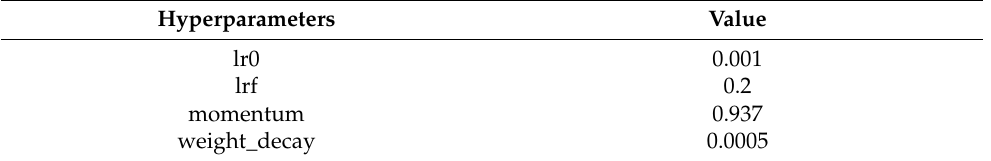
Table 2. The settings for the training hyperparameters.